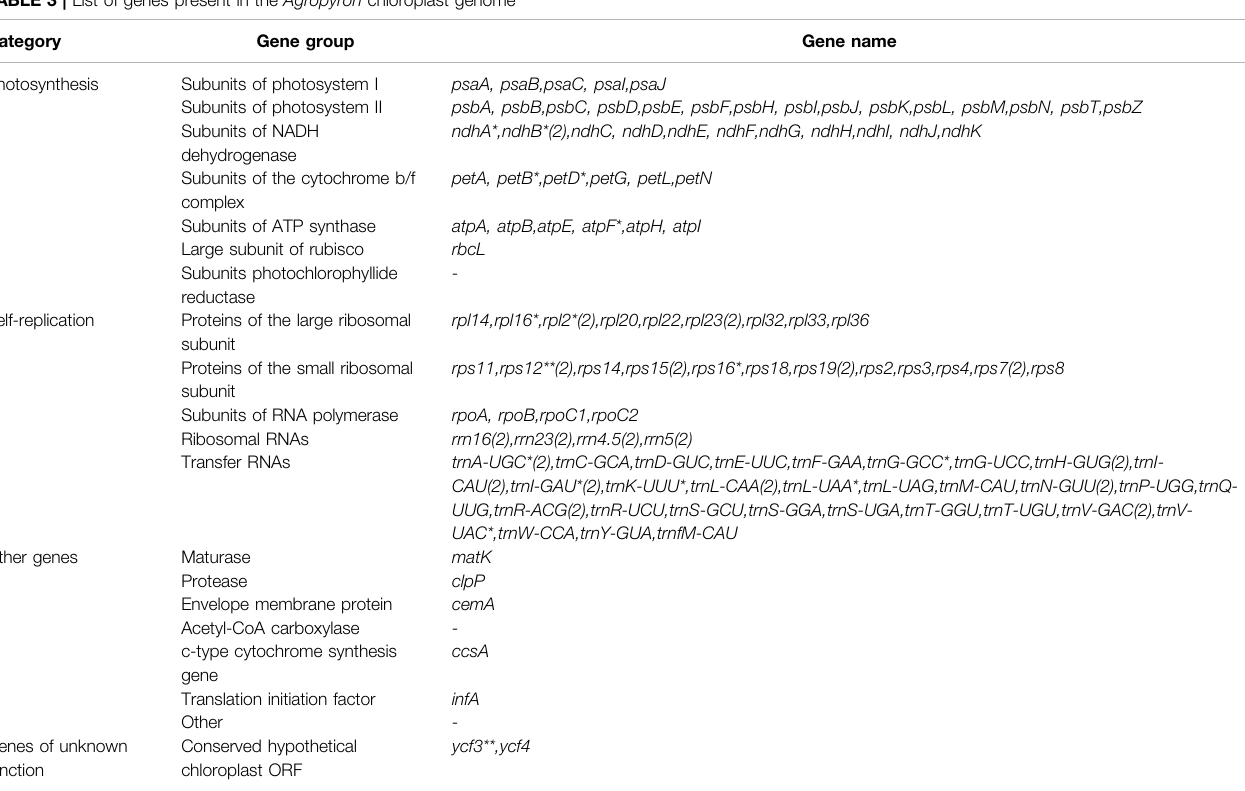
TABLE 3 | List of genes present in the Agropyron chloroplast genome Category Gene group